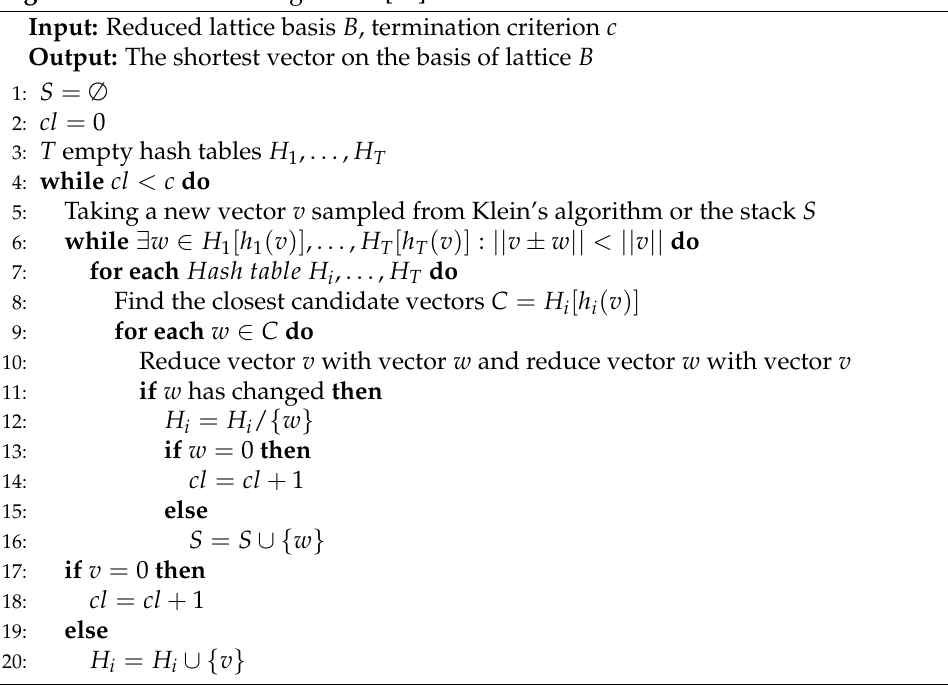
Algorithm 2 HashSieve Algorithm